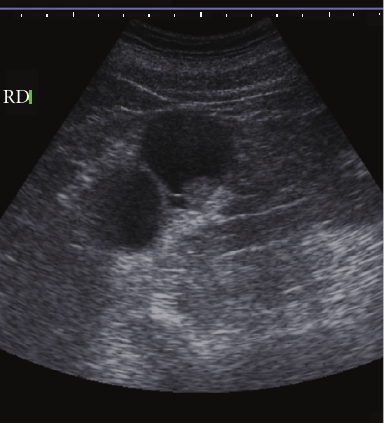
Figure 3: Well-defined hyperechoic small renal mass. Pathologic analysis of the surgical specimen revealed a renal cell carcinoma.